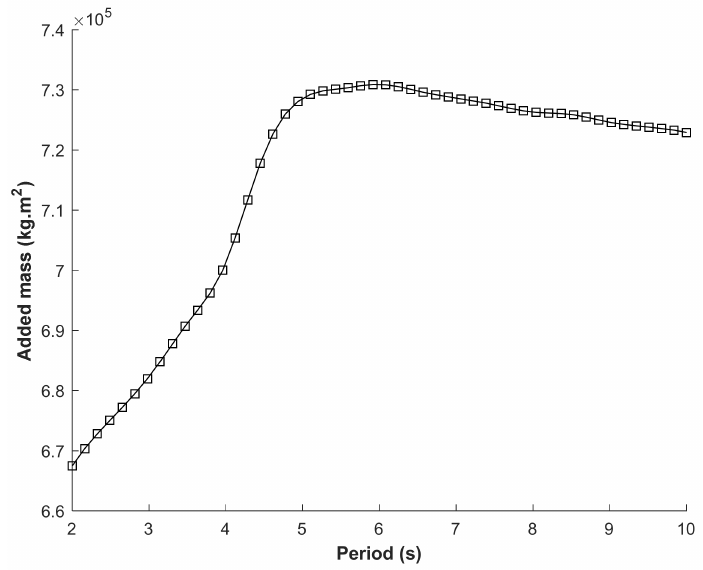
Figure 5. Additional mass curve for pitching.